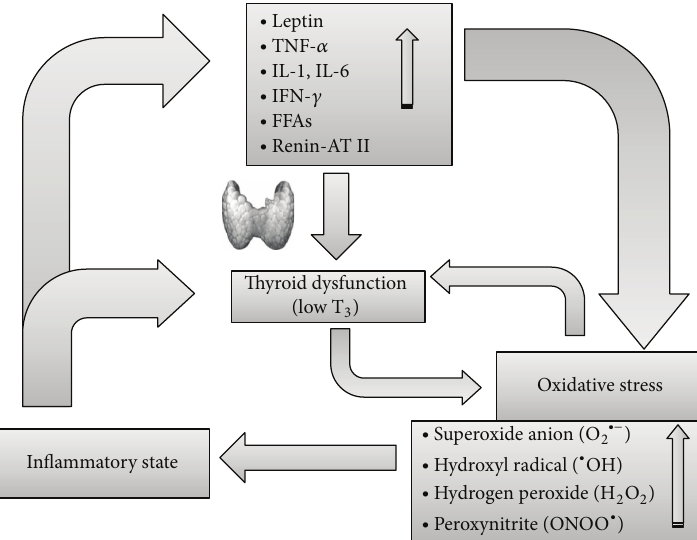
Figure 1: Proposed model of the interrelationships between inflammation, oxidative stress, and thyroid derangement. Inflammation, via hormone and cytokine changes, leads to oxidative stress and also affects thyroid function, causing nonthyroidal illness syndrome or pituitary- thyroidaxisdepression.Atthetissuelevel,hypothyroidismreinforcestheoxidativestress,whichinturnworsenshypothyroidismbyinhibiting deiodinases, thus establishing a vicious circle (see text for further explanations). AT: angiotensin; FFAs: free fatty acids; IFN: interferon; IL: interleukin; TNF: tumor necrosis factor.